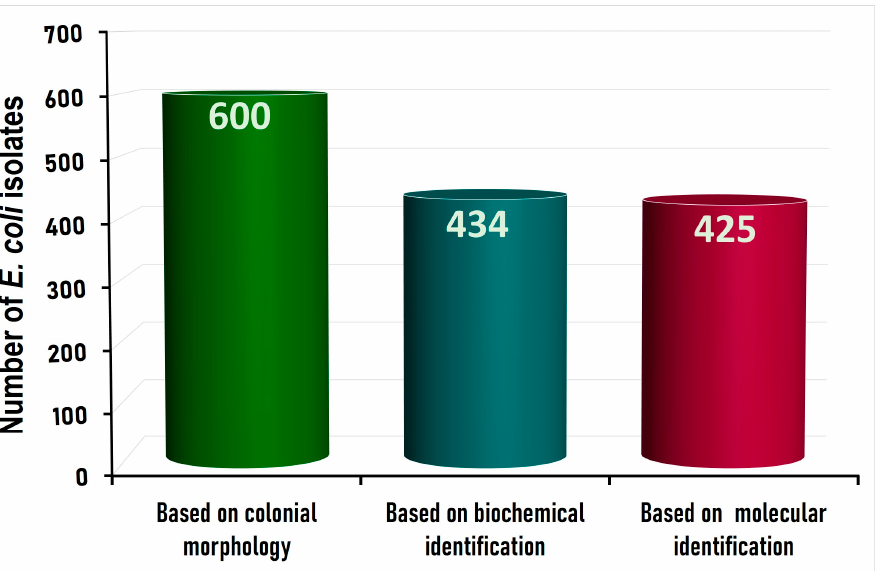
Figure 1. Number of E. coli isolates identified depending on colonial morphology, biochemical and molecular identification.